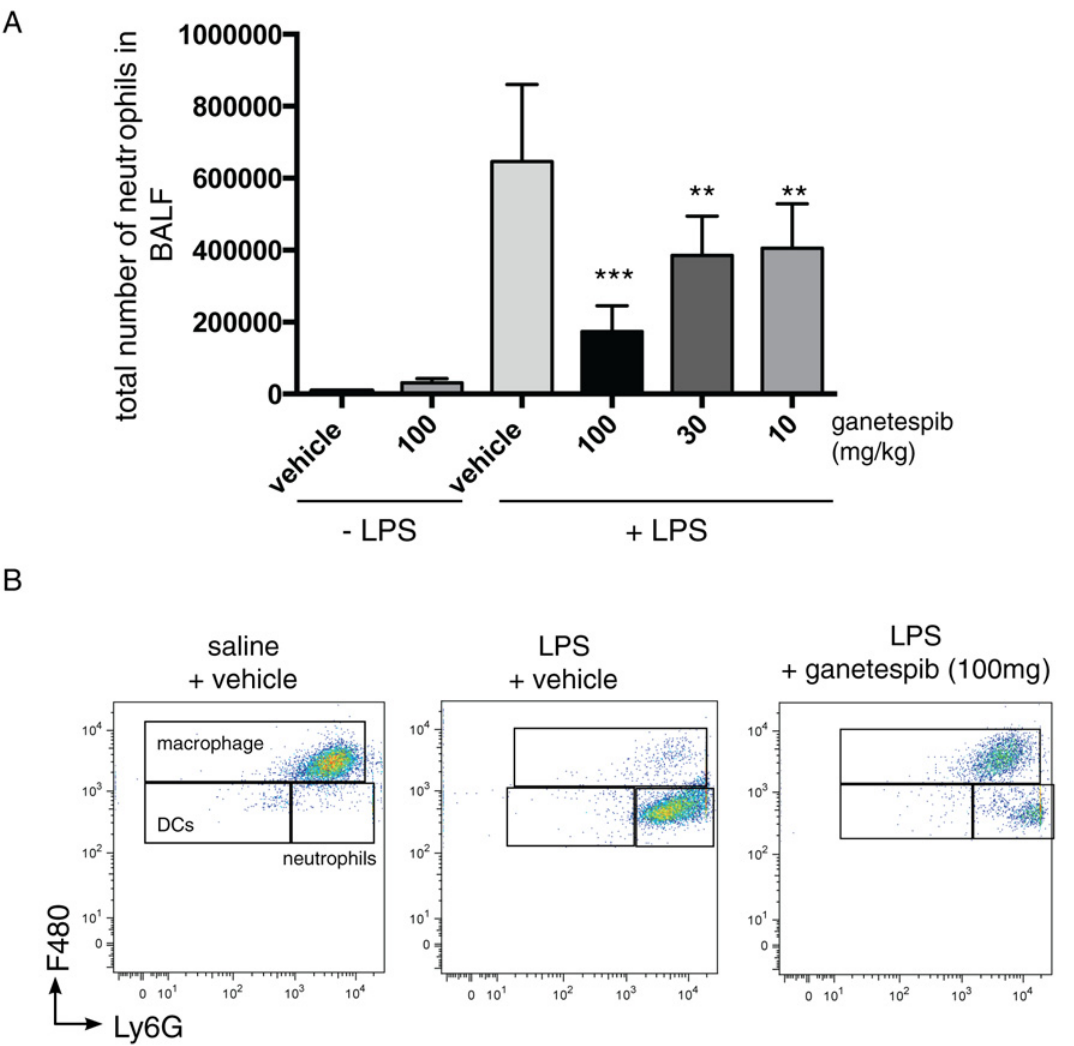
Figure 1. Ganetespib inhibits LPS-induced lung neutrophil recruitment. (A) Histogram showing the total number of neutrophils in bronchoalveolar lavage fluid (BALF) of Balb/c mice treated with (+) or without (-) LPS (10 µ g/mouse, tn) and/or Ganetespib at the indicated dose (mg/kg). BALF was collected 24 hours after Ganetespib administration. Data are mean ± SEM. n = 8 mice per group (100 mg/kg, no LPS; n = 4). ** p < 0.01 compared to LPS/vehicle treated mice. (B) Representative FACS dot plots showing the F4/80 vs Ly6G gating strategy used to defined distinct cellular subsets in BALF of mice treated with or without LPS and/or Ganetespib. Cells are PI - CD45 + and gated for large cells based on forward and side scatter properties. Plots show show 20,000 – 25,000 live (PI - )CD45 + cells. Note the marked suppression of neutrophil influx by